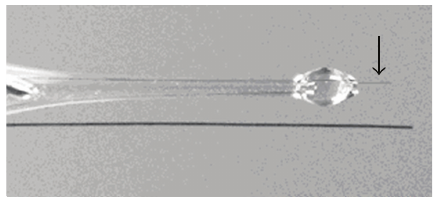
Figure 1: Carbon fiber microelectrode, comparison to human hair.